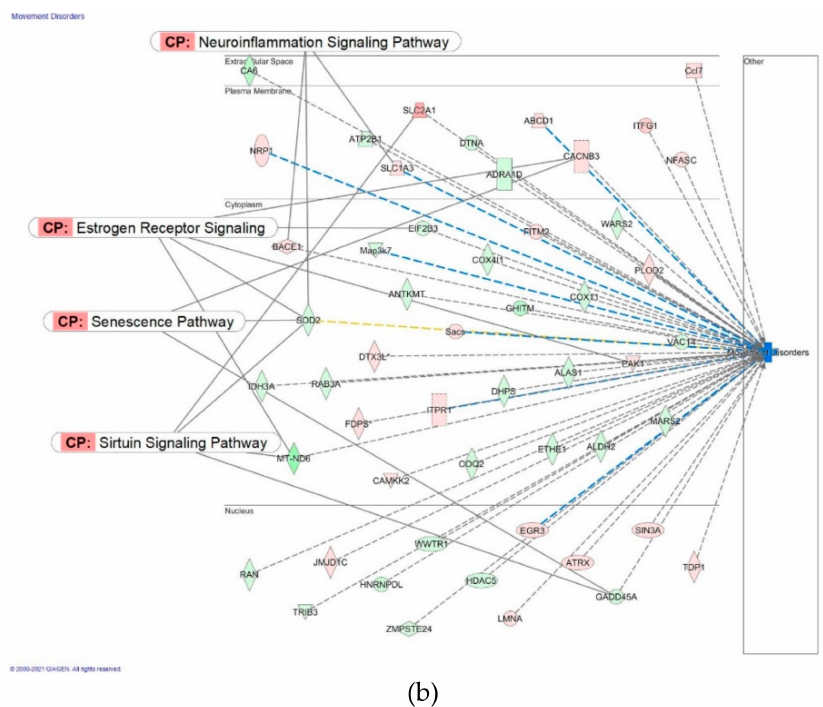
Figure 21. Predicted effects of Rg5 on movement disorders: ( a ) activation (brown) at a concentration of 100 µ M; ( b ) predicted inhibition (blue) at a concentration of 1 aM.